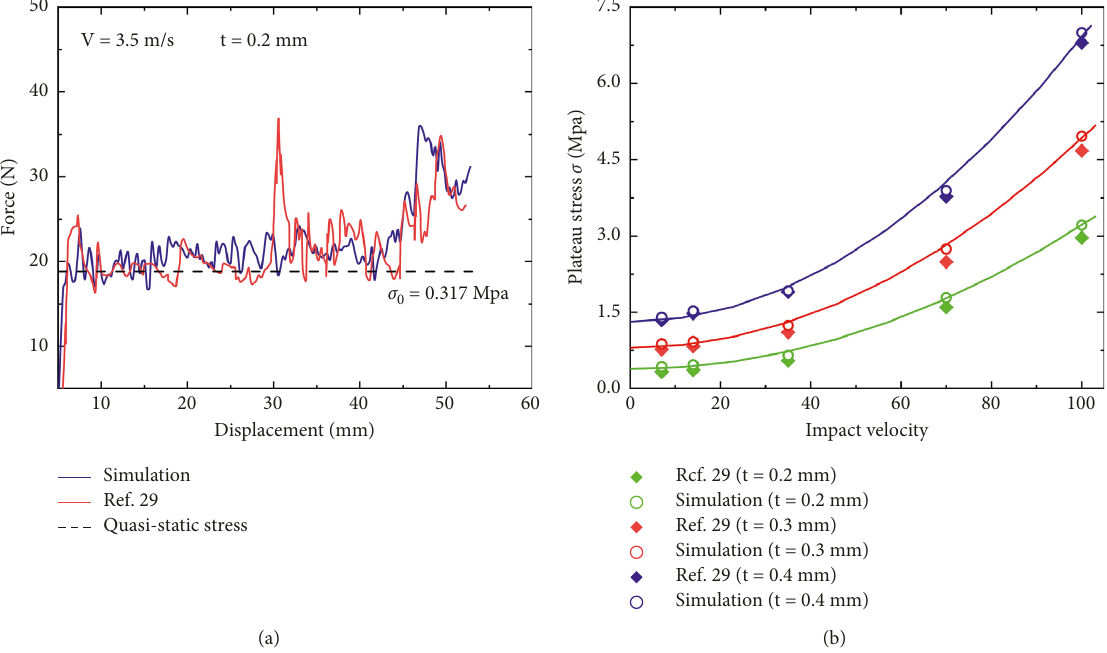
Figure 4: The comparison between finite element model and [29]. (a) The force-displacement curve of finite element model, (b) the result of finite element and